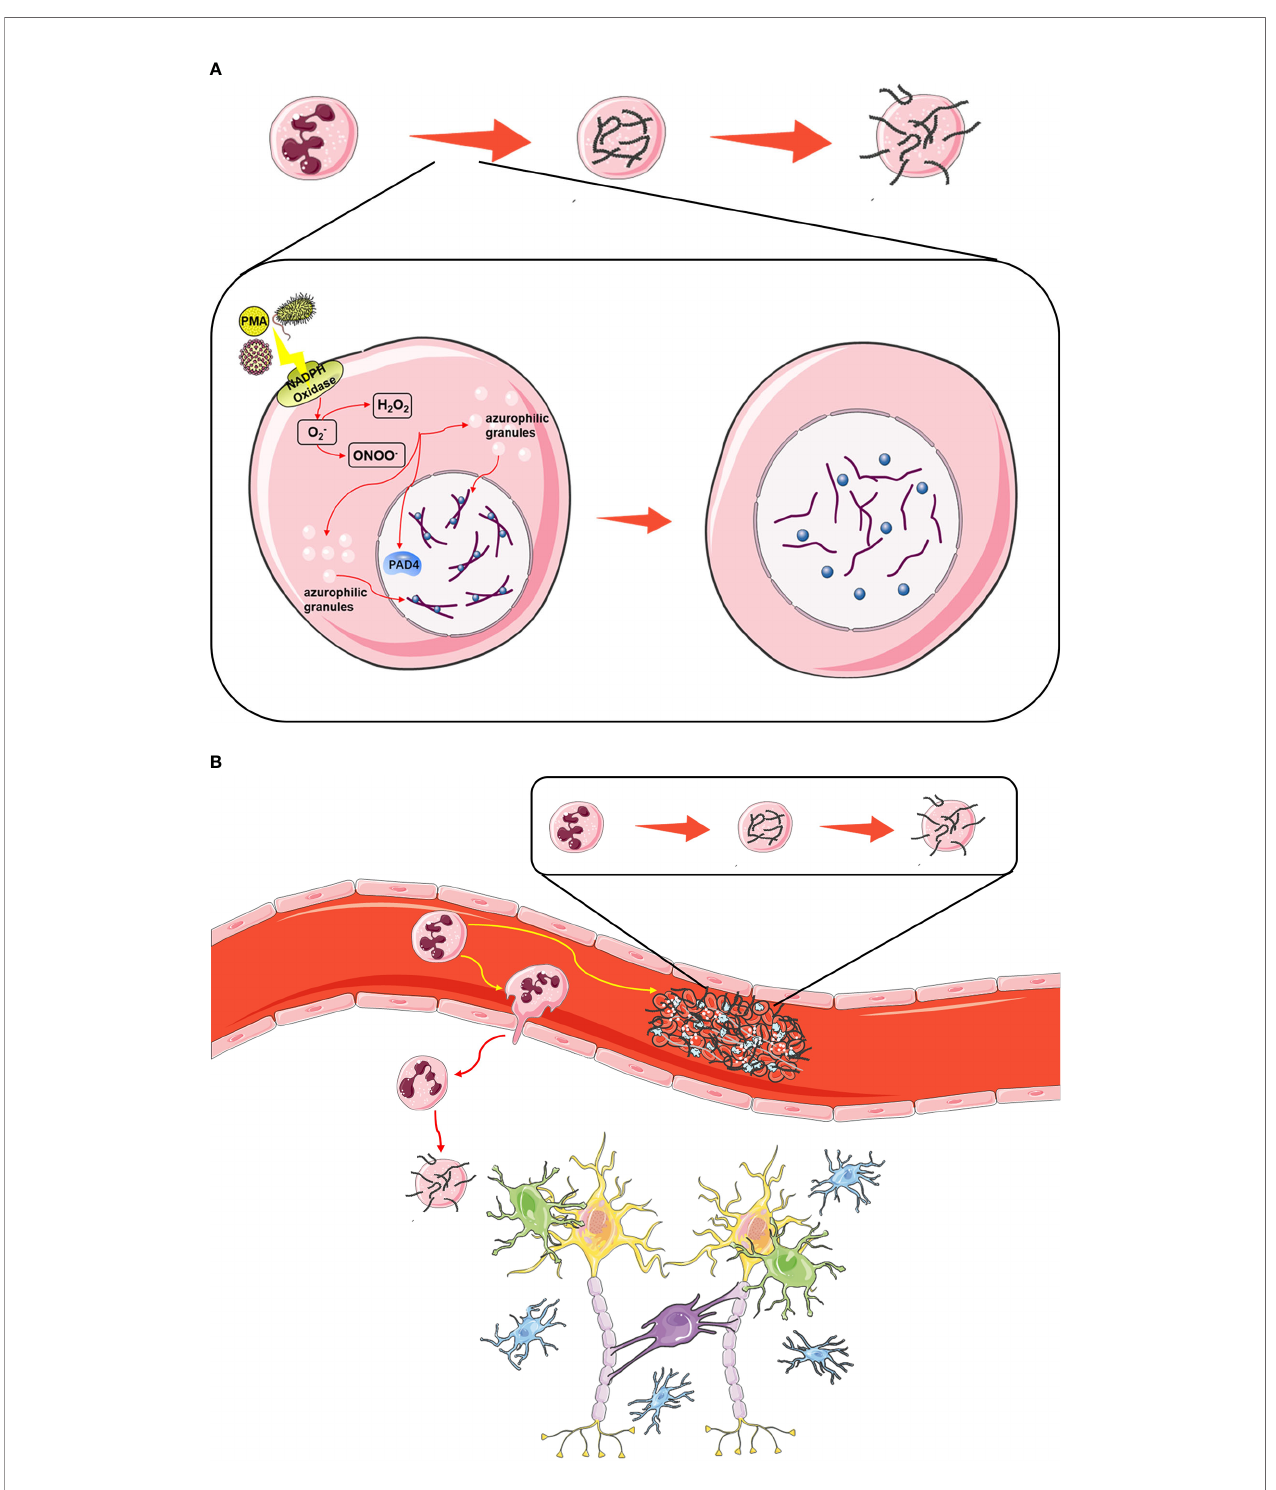
FIGURE 4 | (A) The classic pathway of NETosis. Upon stimulation, ROS produced by NADPH oxidase activate the binding of PAD4 to citrullinated histones, leading to the unfolding of chromatin, and induce the translocation of enzymes such as NE and MPO in azurophilic granules to the nucleus, where they exacerbate the dissociation of histones and DNA. Finally, after the nuclear membrane and cytomembrane are dissolved, cell components including DNA, histones and granzymes are released into the intercellular space. (B) The effect of NETosis in ischemic stroke. Upon stimulation, neutrophils in the thrombus release NETs, which act as scaffolds to consolidate the thrombus. Some circulating neutrophils migrate from the blood stream into brain tissue, and they also release NETs to exacerbate neural